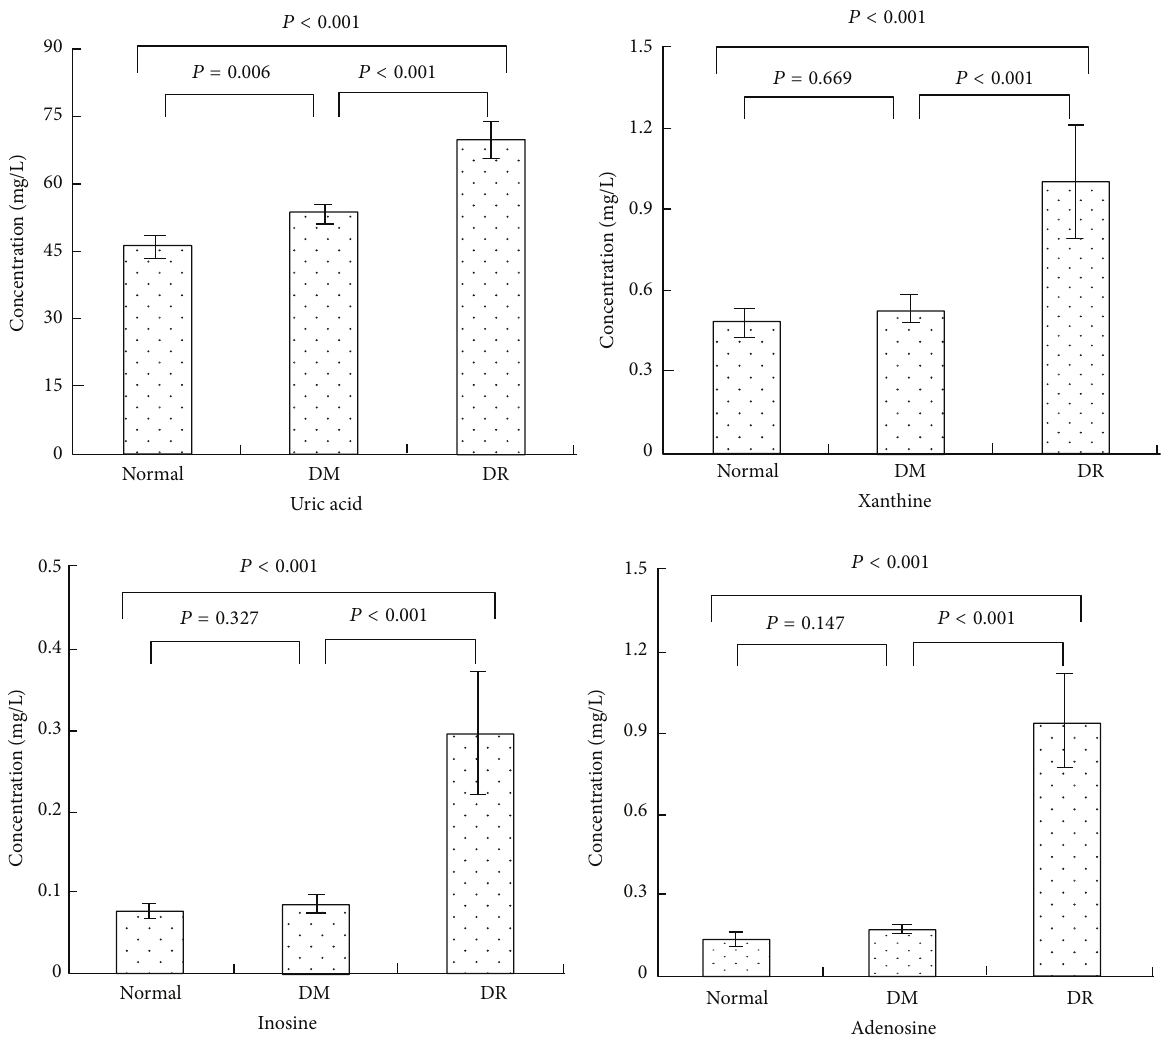
Figure 3: Comparison of four potential biomarkers concentrations in healthy subjects (normal), type 2 diabetes patients without retinopathy (DM), and type 2 diabetes patients with retinopathy (DR). Compared to the group of normal and DM, DR subjects had significantly higher mean plasma concentrations of inosine ( 𝑃 < 0.001 , 𝑃 < 0.001 ), adenosine ( 𝑃 < 0.001 , 𝑃 < 0.001 ), uric acid ( 𝑃 < 0.001 , 𝑃 < 0.001 ), and xanthine ( 𝑃 < 0.001 , 𝑃 < 0.001 ). The group of DM had significantly higher mean plasma concentrations of uric acid ( 𝑃 = 0.006 ) compared to the normal